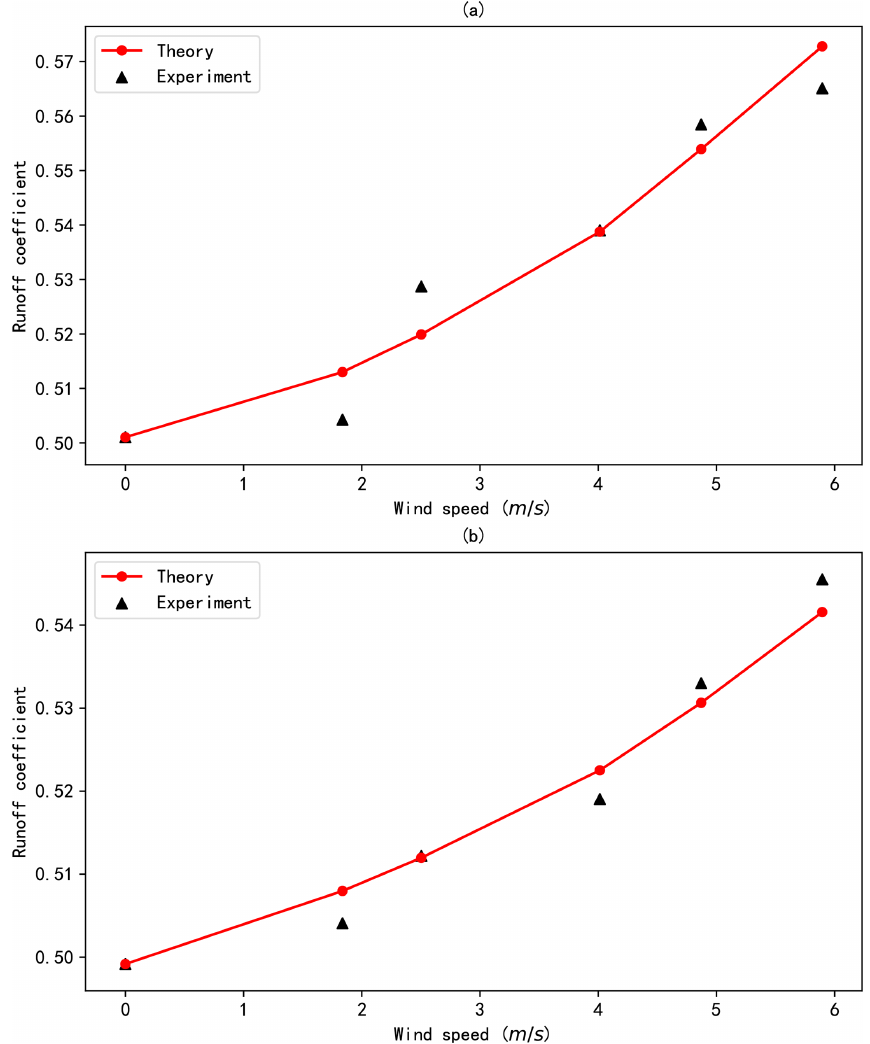
Figure 12. Comparison between the theoretical and experimental runoff coefficients for different wind speeds under rainfall types 1 (a) and 2 (b)